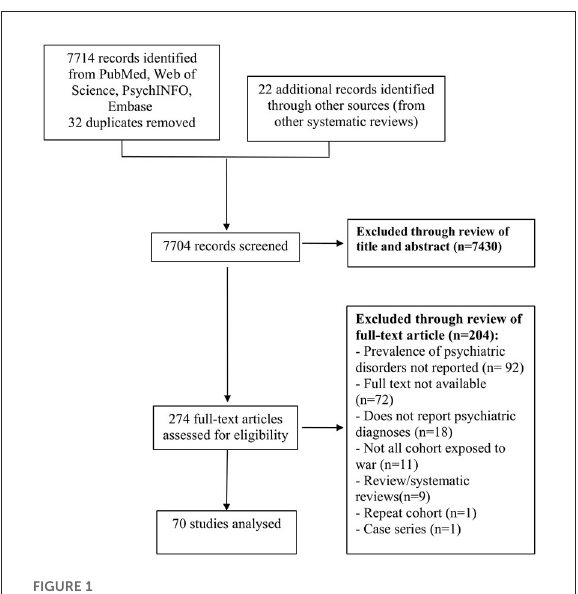
FIGURE1 PRISMA flowchart detailing search strategy, inclusion and exclusion